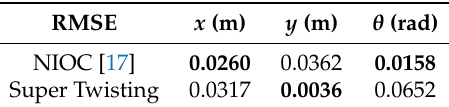
Table 4. Tracking error comparison of NIOC [17] and a Super Twisting controller. Bold values highlight the best result.